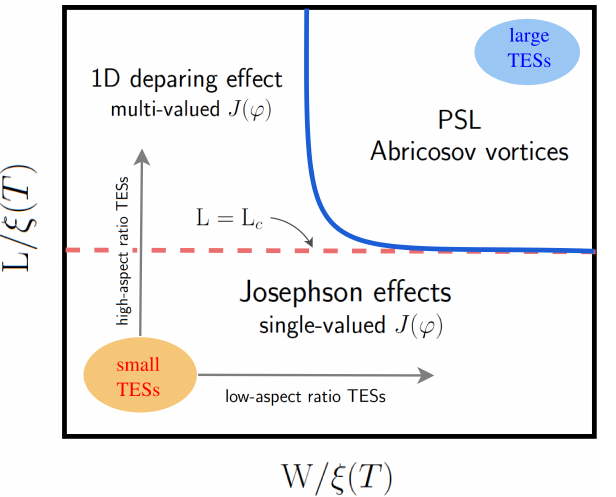
Figure 3. Possible physical states in which a TES of different size likely operates. Reproduced after [24,43], by permission from American Physical Society and the